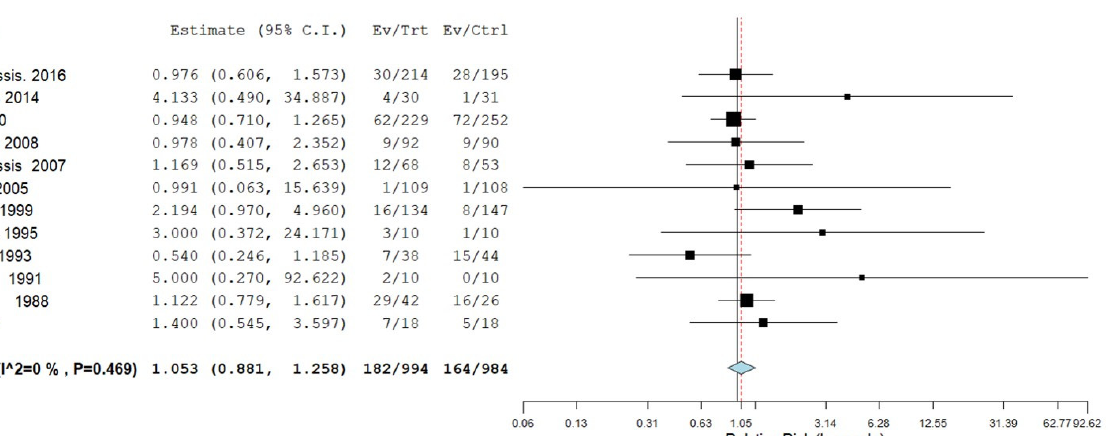
Figure 2. Results of the Cochrane Risk of Bias (CROB2) for the included trials. References cited in the figure are: [37–49].